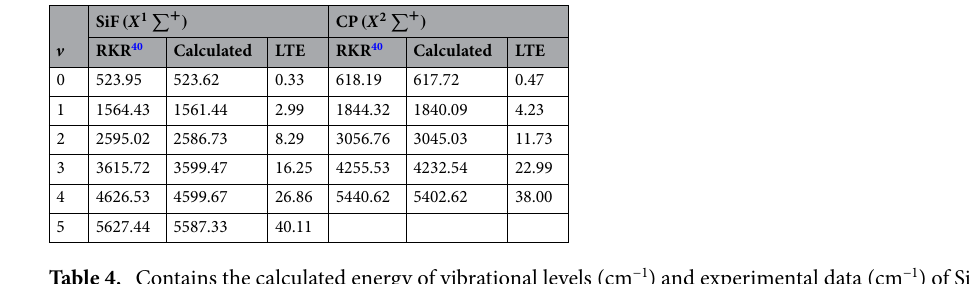
Table 4. Contains the calculated energy of vibrational levels (cm −1 ) and experimental data (cm −1 ) of SiF and CP molecules for the modified shifted Morse potential function.